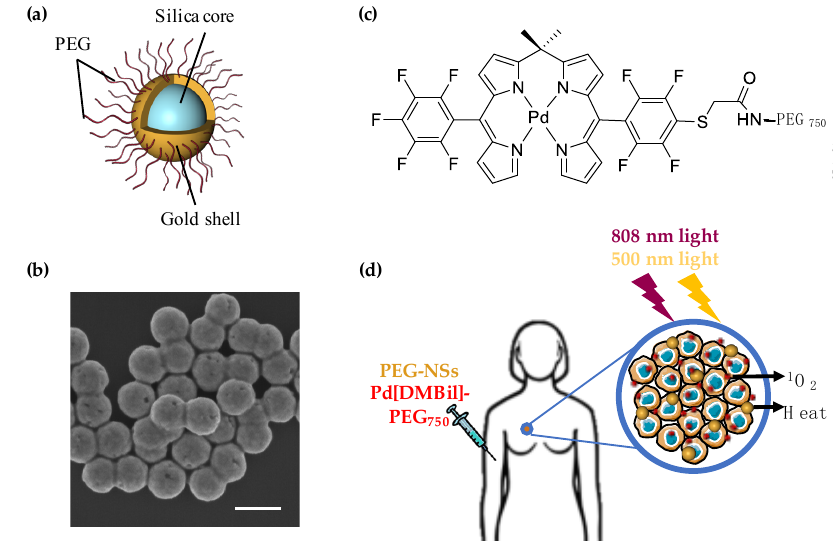
Figure 1. ( a ) Schematic of poly(ethylene glycol) nanoshells (PEG-NSs) used to induce photothermal therapy (PTT); ( b ) Scanning electron micrograph showing the size and monodispersity of NS. Scale = 200 nm; ( c ) Chemical structure of Pd[DMBil1]-PEG 750 photosensitizers used to mediate photodynamic therapy (PDT); ( d ) Scheme showing the proposed therapeutic strategy of dual PTT/PDT to treat triple negative breast cancer (TNBC). First, PEG-NSs and Pd[DMBil1]-PEG 750 would be intravenously injected and accumulate within solid tumors based on the enhanced permeability and retention (EPR) effect. Then, an 808 nm continuous wave laser and 500 nm light would be applied to activate PEG-NSs and/or Pd[DMBil1]-PEG 750 , respectively, to produce heat and singlet oxygen that is toxic to the surrounding cancer cells.